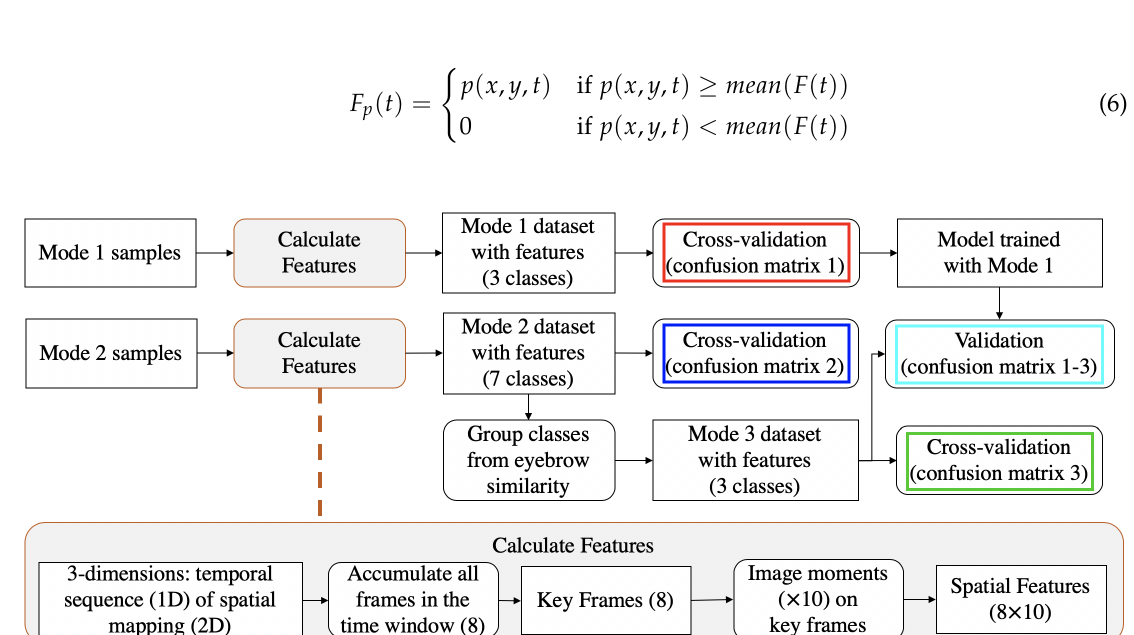
Figure 4. Flowchart of the data analysis process in Experiment 1.